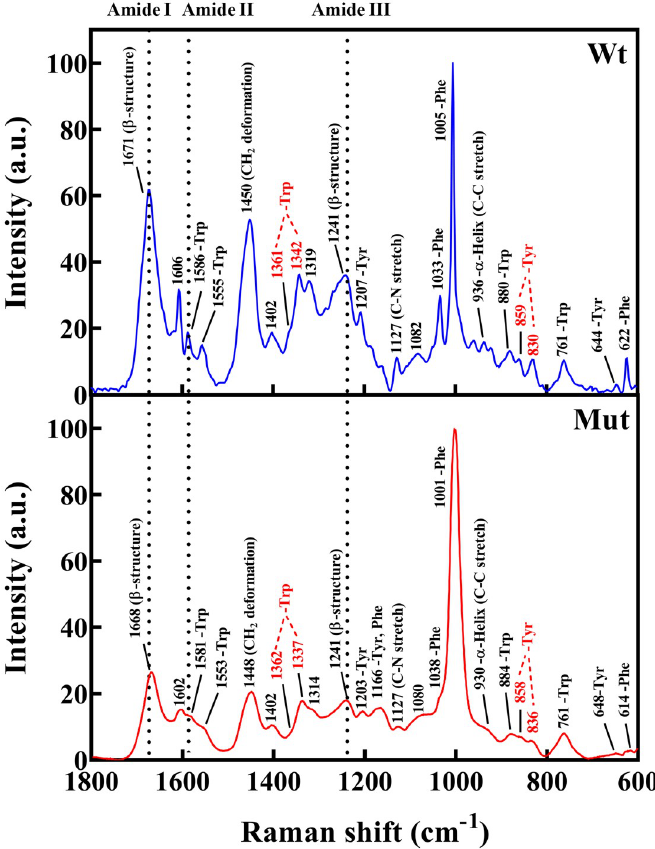
Fig 4. Raman spectra of human wild-type and D109A mutant α B-crystallin proteins. Similar to FTIR study, the curve fitting and deconvolution analysis of Raman spectra in amide I region was carried out and the secondary structural contents of α B-crystallin proteins were obtained. The results of both Raman and FTIR studies exhibited a reduction in β -sheet and turn contents of the D109A mutant protein, as well as the enhancement in the α -helical and unordered structures when compared with the secondary structural contents of wild-type protein counterpart (S5 Fig)